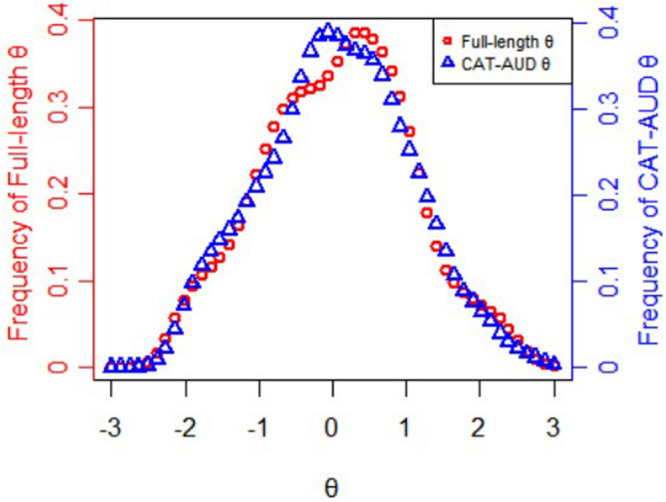
Frequency distributions of theta values estimated via the full-length item bank and the CAT-AUD at a given SE level (SE ≤ 0.32).